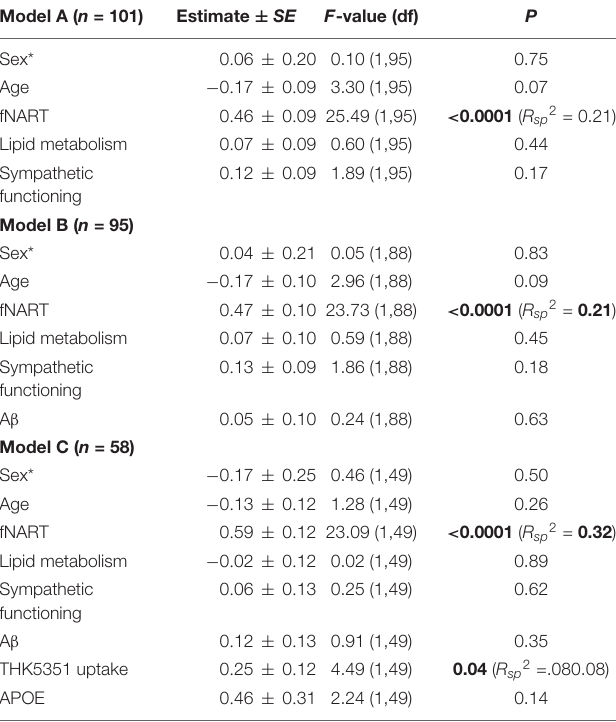
TABLE 4 | Statistical outcome of GLMM examining associations between executive functions (dependent variable) and: (A) scores of cognitive reserve and allostatic load ( n = 101); (B) scores of cognitive reserve and allostatic load, and A β ( n = 95); (C) scores of cognitive reserve and allostatic load, A β , tau, and APOE ( n = 58).